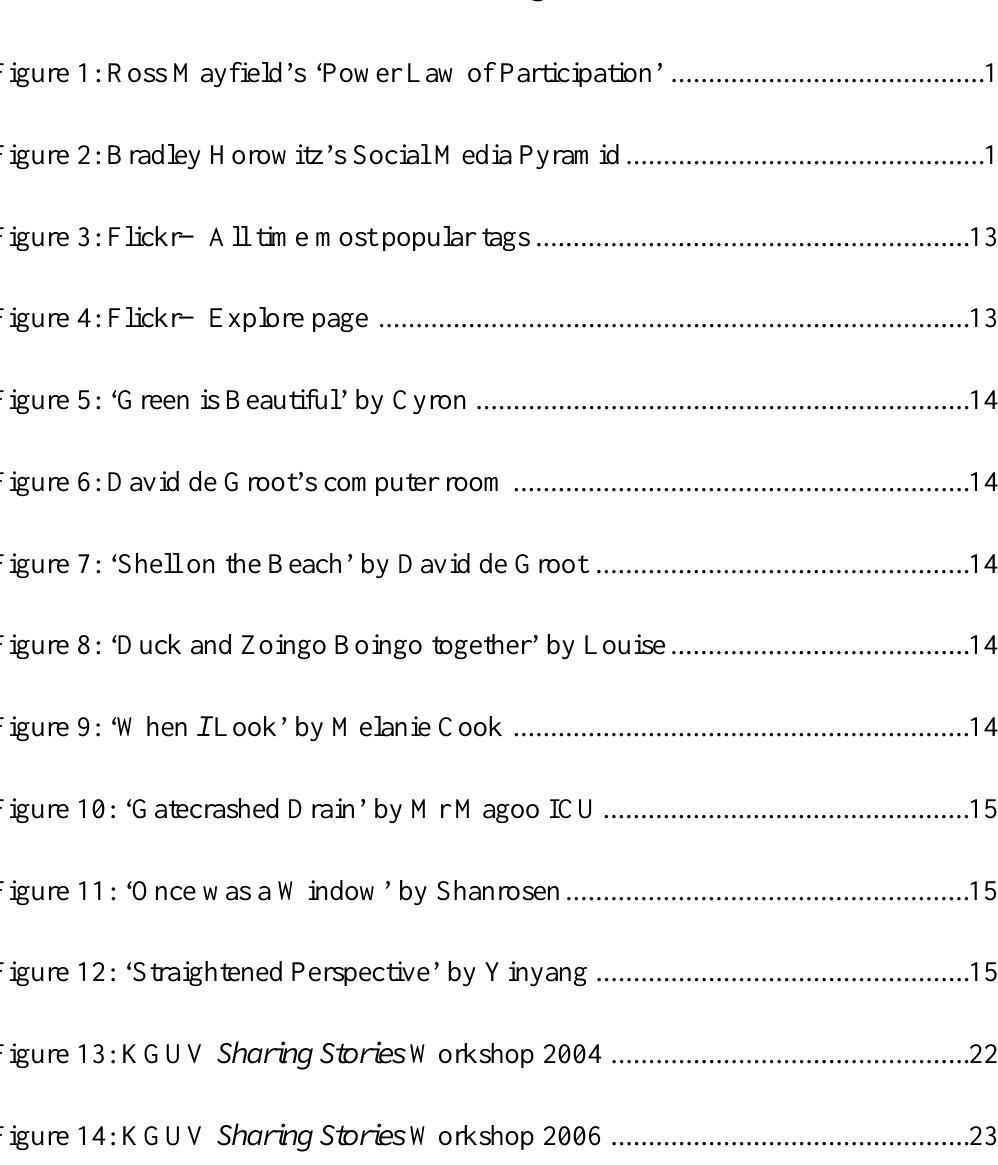
Figure 1: Ross Mayfield’s ‘Power Law of Participation’ .......................................... 12 Figure 2: Bradley Horowitz’s Social Media Pyramid ................................................ 15 Figure 3: Flickr—All time most popular tags .......................................................... 133 Figure 4: Flickr—Explore page ............................................................................... 135 Figure 5: ‘Green is Beautiful’ by Cyron .................................................................. 144 Figure 6: David de Groot’s computer room ............................................................. 145 Figure 7: ‘Shell on the Beach’ by David de Groot .................................................. 146 Figure 8: ‘Duck and Zoingo Boingo together’ by Louise ........................................ 147 Figure 9: ‘When I Look’ by Melanie Cook ............................................................. 148 Figure 10: ‘Gatecrashed Drain’ by Mr Magoo ICU................................................. 150 Figure 11: ‘Once was a Window’ by Shanrosen ...................................................... 151 Figure 12: ‘Straightened Perspective’ by Yinyang .................................................. 152 Figure 13: KGUV Sharing Stories Workshop 2004 ................................................ 229 Figure 14: KGUV Sharing Stories Workshop 2006 ................................................